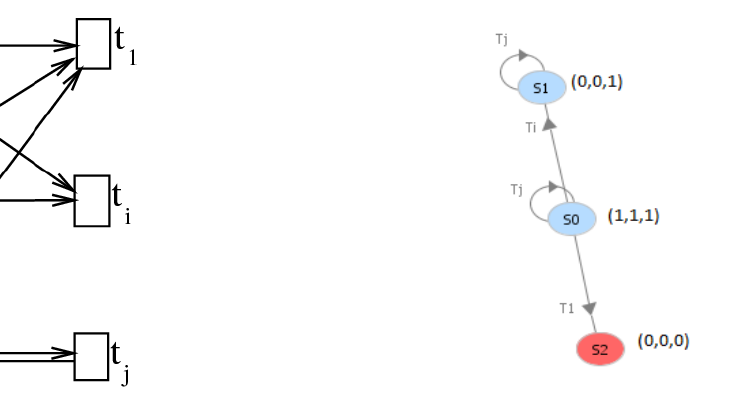
Figure 6. Petri net containing subnet-2 and its coverability graph